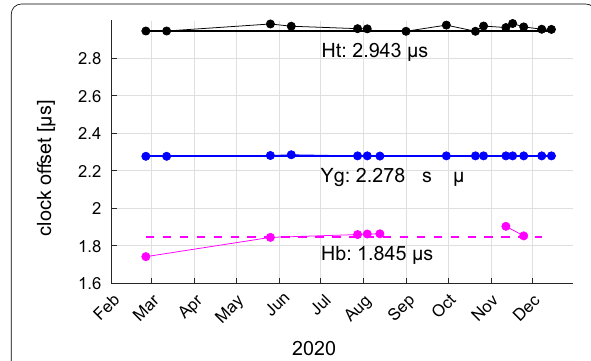
Fig. 2 Correlation clock offsets corrected by τ fmout − gps measurements displayed as dots per SI session in 2020 for Ht (black), Yg (blue), and Hb (magenta). The solid lines represent the known IVS peculiar offsets for Ht and Yg, whereas the dashed line represents the estimated peculiar offset for Hb based on SI